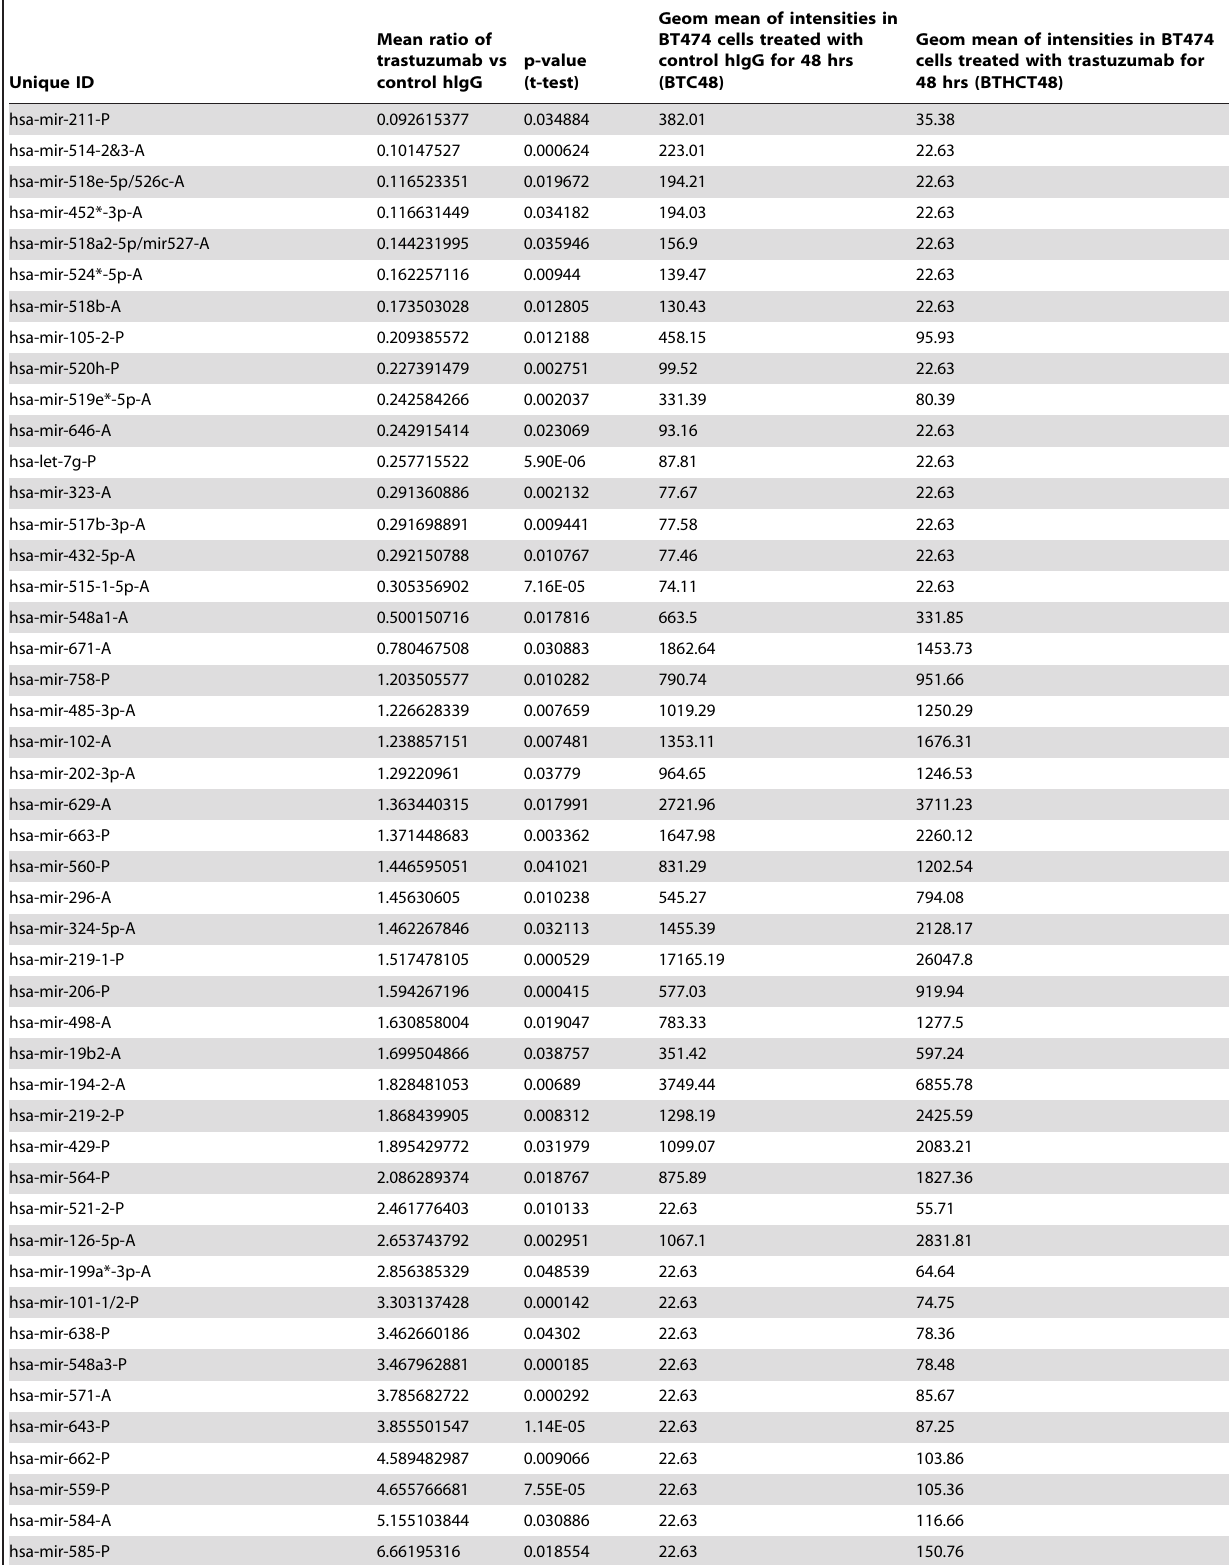
Table 2. miRNAs affected by trastuzumab in BT474 cells.